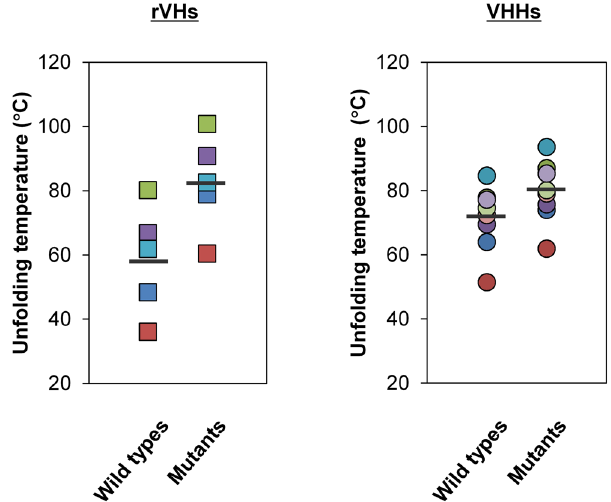
Figure 4. Comparison of increase in the unfolding temperature of rVHs and VHHs due to C54-C78 introduction. Unfolding temperature of wild types and their corresponding C54-C78 mutants are indicated as the same symbol and color for rVH and VHH. Average thermal unfolding temperatures of each group are indicated with bold lines (rVHs = 58.7 °C, mutant rVHs = 82.7 °C, VHHs = 71.9 °C, mutant VHHs = 80.9 °C). The unfolding temperatures of VHHs were quoted from refs